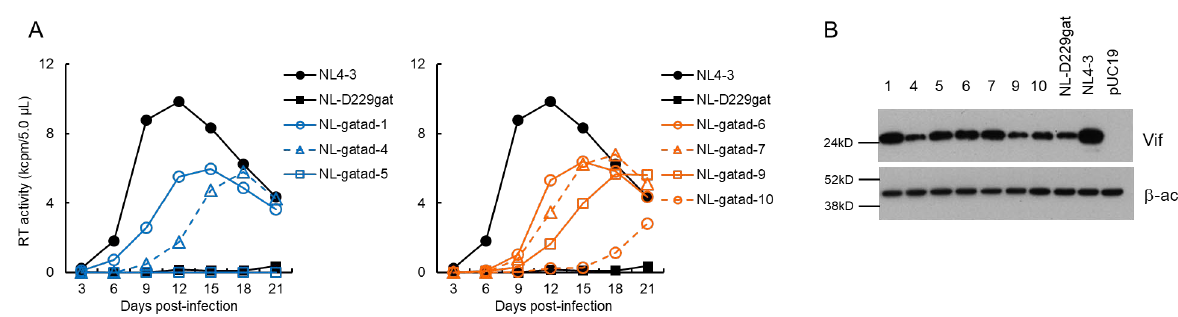
Figure 3. Characteristics of viral clones constructed from adapted NL-D229gat. ( A ) Growth kinetics. Viruses prepared from HEK 293T cells transfected with the indicated pro-viral clones were inoculated into H9 cells (1 × 10 4 RT units/10 5 cells). Virus replication was monitored by the virion-associated RT activity in the culture supernatants. This experiment was performed once to select viral clones that have the ability to grow in cells. Viral replication kinetics of WT NL4-3 and a parental NL-D229gat are presented in both panels for easy comparison. ( B ) Vif expression levels. HEK 293T cells were transfected with the indicated pro-viral clones. On day 1 post-transfection, cell lysates were prepared and subjected to Western blotting analysis using anti-Vif and anti- β -actin antibodies. An empty vector pUC19 and an authentic HIV-1 NL4-3 clone were used as negative and positive controls, respectively. Numbers correspond to those for the adapted clones shown in panel ( A ). Representative data from two independent experiments are shown. Table 1. Mutations found in adapted clones which exhibit similar Vif expression levels to that in the NL-D229gat clone. NL-gatad-4 NL-gatad-9 Nt Change Region